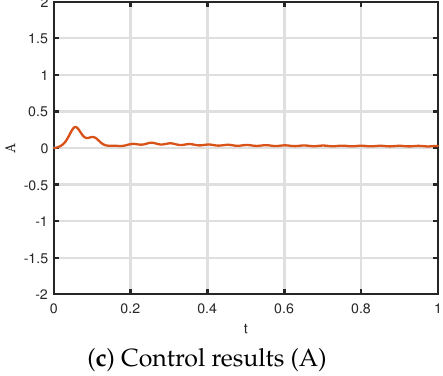
Figure 8. Control effects with initial conditions ( x P = 0.001, y P = 0.011).